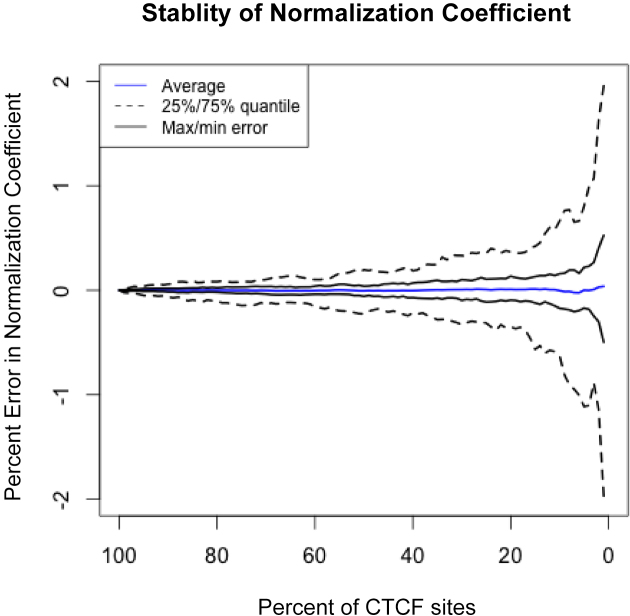
Stability of CTCF derived normalization coefficient. Stability of the CTCF derived normalization coefficient was analyzed by sub-sampling CTCF peaks before undertaking the calculation (between 1 and 100% of total sites) at random. This analysis was repeated 100 times to model the variability of the result.